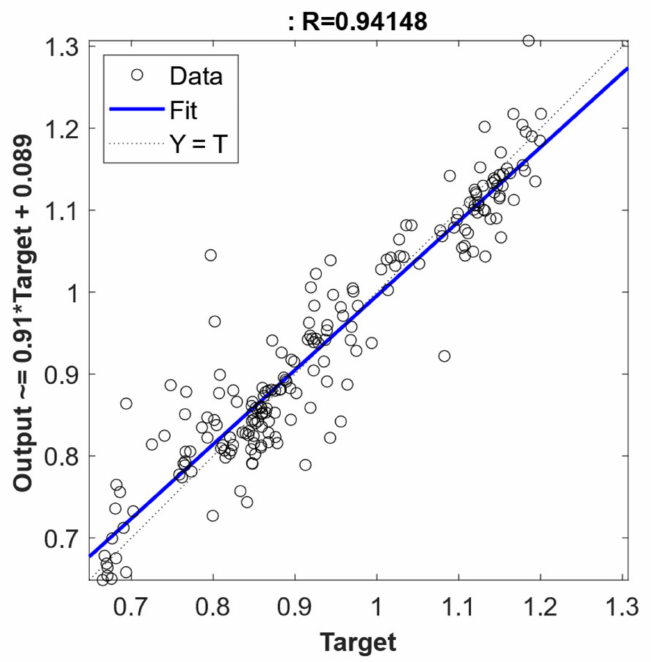
Figure 7. Regression analysis for the IT2AIFLS on the Poland electrical load dataset for test